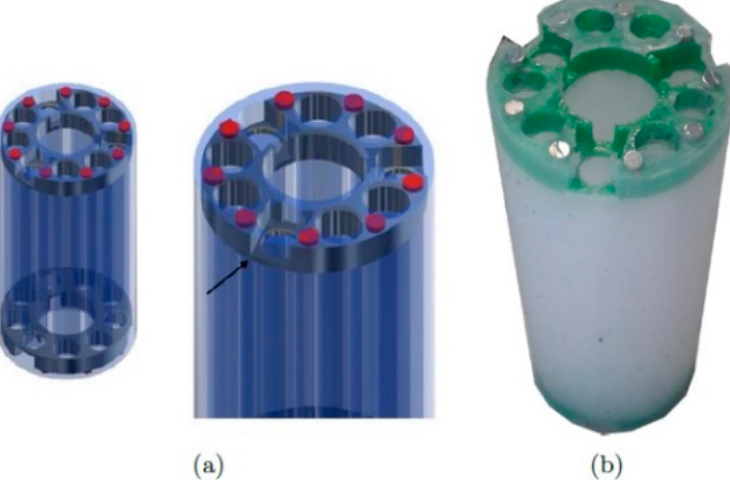
Figure 6. One of three silicone segments. ( a ) the CAD design, and ( b ) the actual segment. The red elements in the CAD represent the magnets, which are located in the green PLA disc. Source: au- thors.